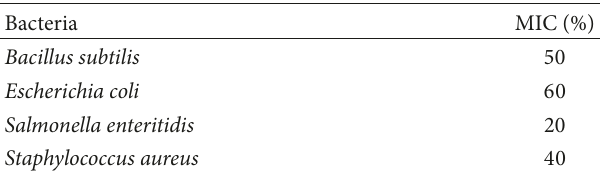
Table 2: Minimum inhibitory concentration of FFAs against four types of